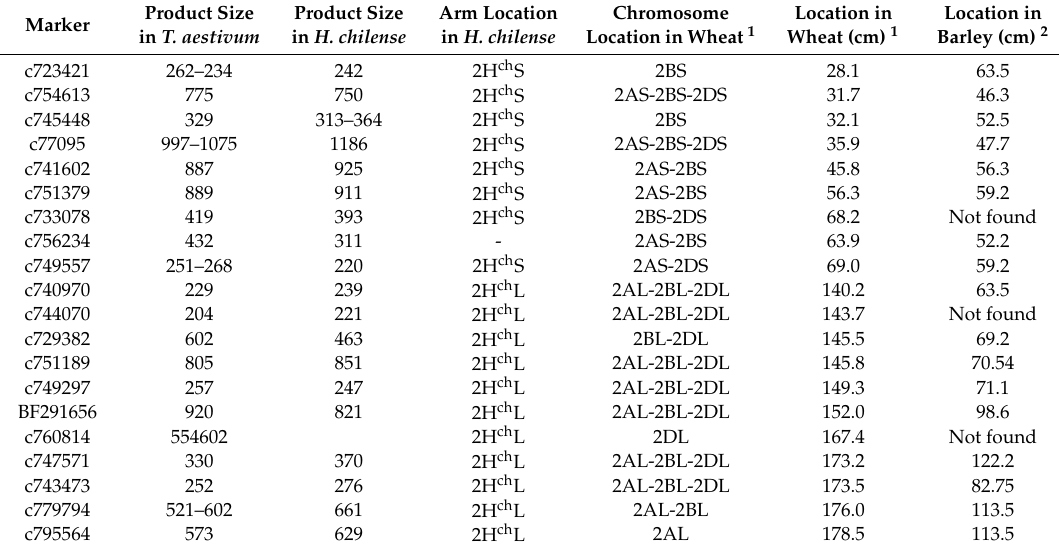
Table 2. Characterization and chromosome localization of wheat conserved orthologous set (COS) markers on H. chilense chromosome 2H ch